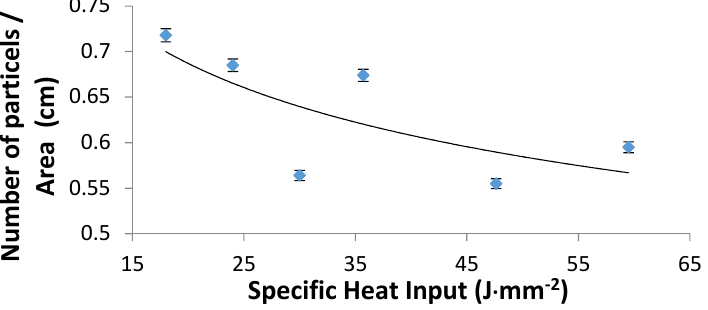
Figure 8. Number of particles per unit area of the clad layer versus the specific heat input.